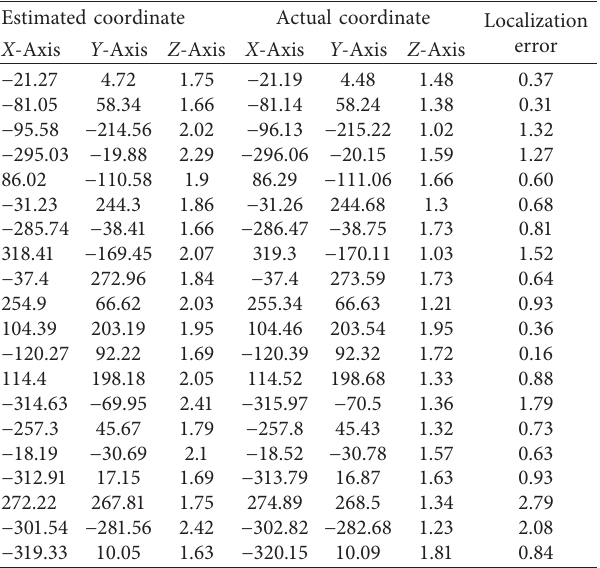
Table 2: Target 3D location results for Test data 1.